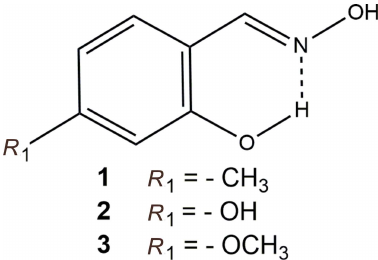
Table 1 Hydrogen-bond geometry (A˚ , (cid:2) ) for 1